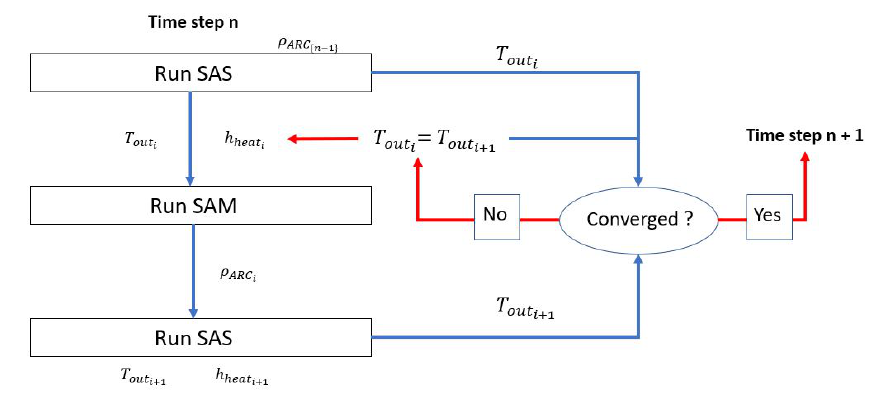
Figure 4: Picard iteration algorithm used in the external